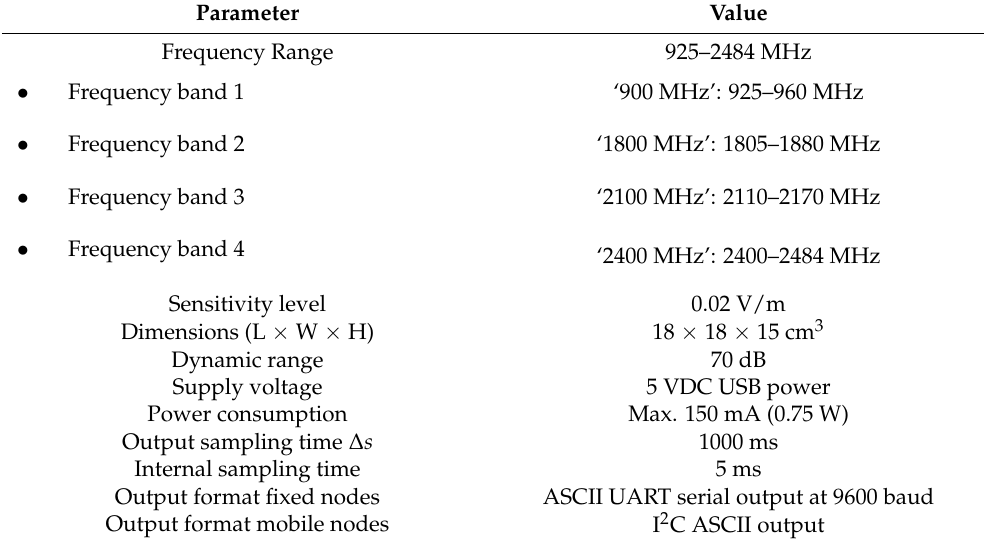
Table 1. Specifications of the radiofrequency (RF) electromagnetic field (EMF)